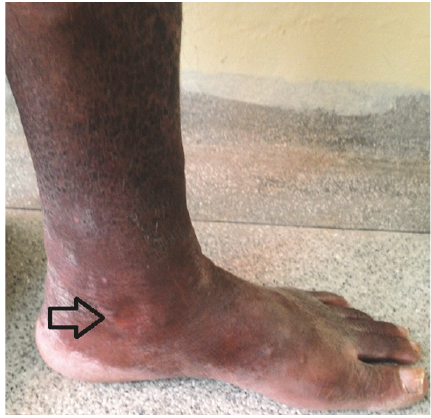
Figure 4: Case 5: patient with edema after recovered DVT in left